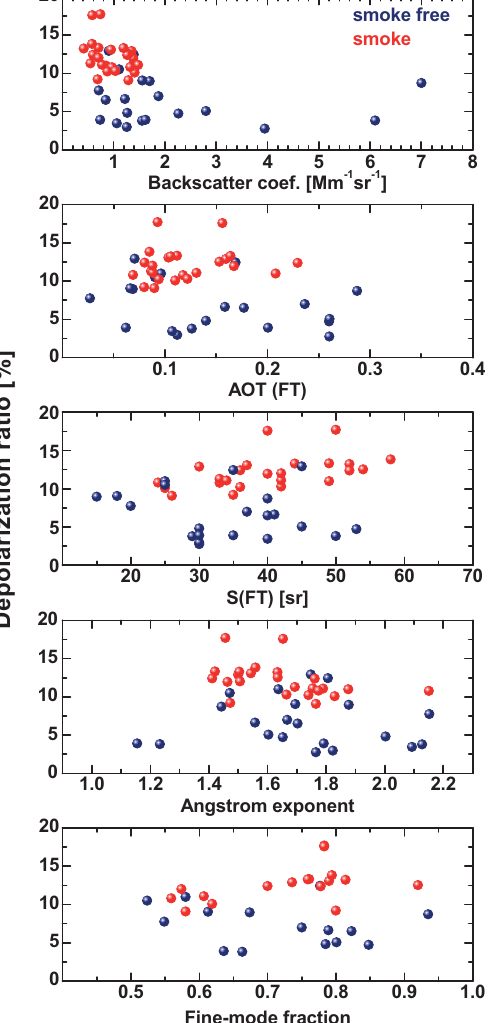
Figure 8. Range of observed values of the particle backscatter co- efficient (mean value of the lofted aerosol layers), free-tropospheric aerosol particle optical thickness AOT(FT), lidar ratio S( FT ) in the lofted aerosol layers, Ångström exponent for the total vertical column, and fine-mode fraction (regarding the total tropospheric 500nm AOT) for the Turkish fire-smoke cases (red circles) and the cases without smoke from Turkey (blue circles). All values (circles) are given as a function of layer-mean particle linear depolarization ratio to better distinguish between fire-smoke and smoke-free